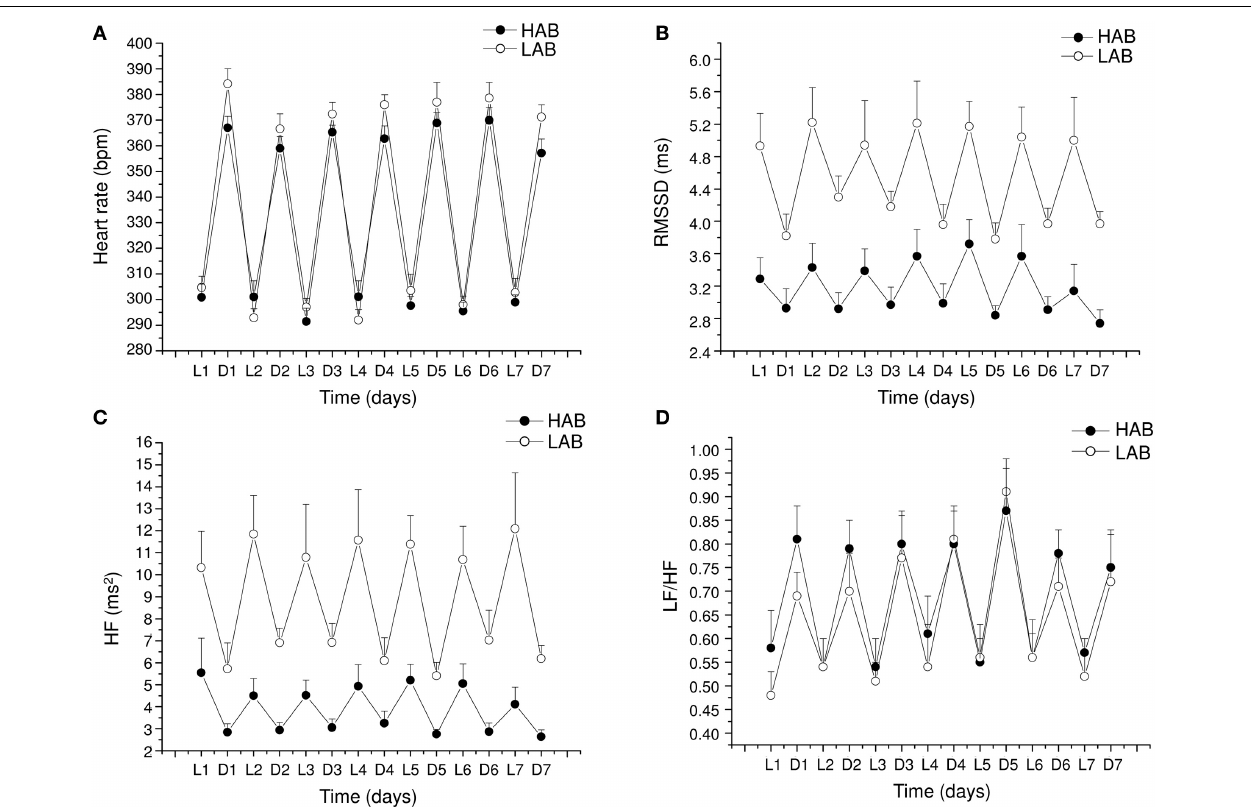
FIGURE 4 | Daily rhythms of (A) heart rate, (B) RMSSD, (C) spectral power in HF band (0.75–2.5Hz) and (D) LF (0.2–0.75Hz) to HF ratio in 4-month-old Wistar rats selectively bred for either high (HAB, n = 10) or low (LAB, n = 10) anxiety-related behavior. These values (reported as means ± SEM) were obtained by averaging multiple 2-min